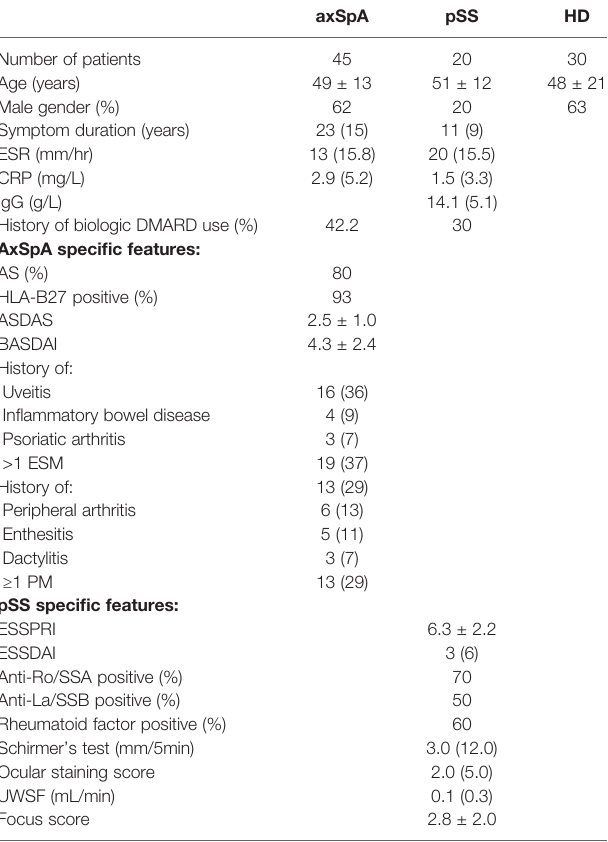
TABLE 1 | Characteristics of axSpA, pSS patients and healthy donors. axSpA pSS